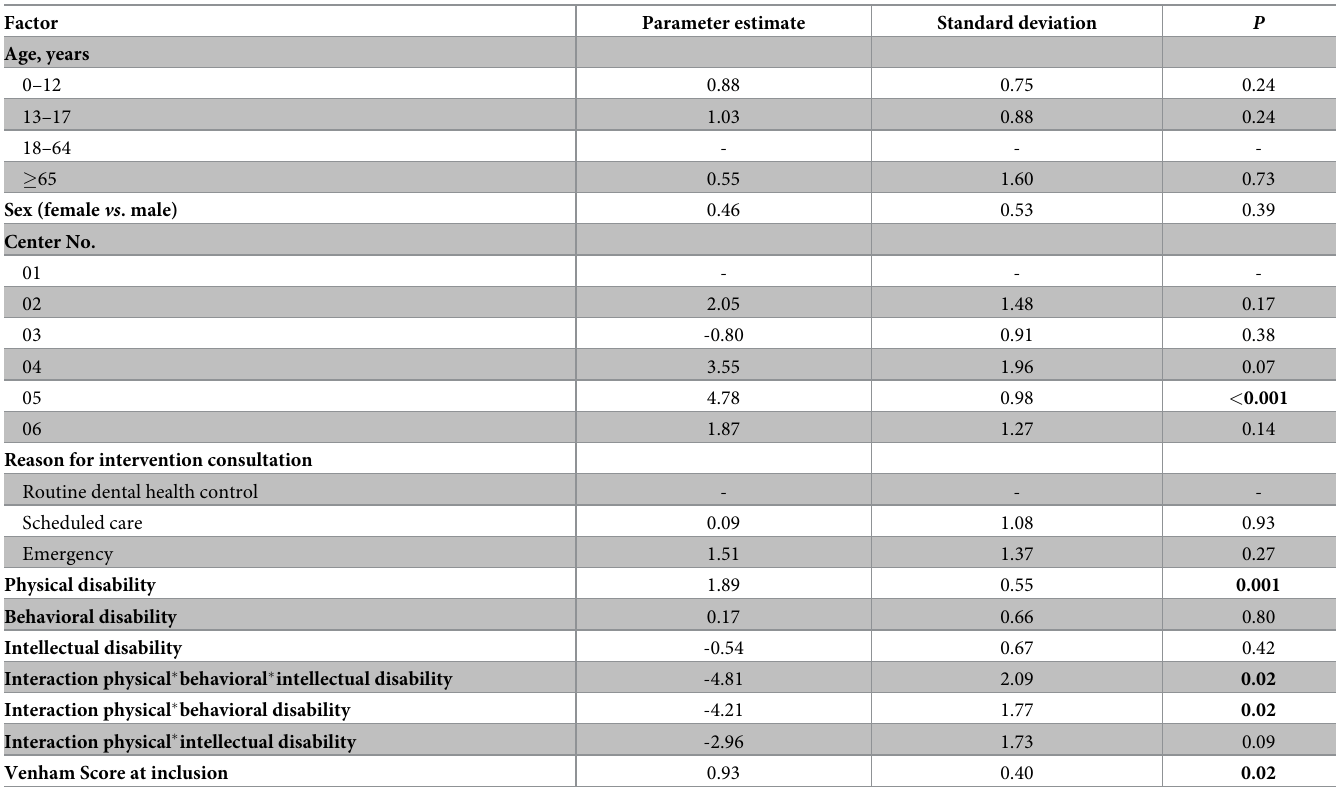
Table 4. Logistic regression analysis of factors that associated with spatula-induced change in Total Oral Accessibility Score ( n =